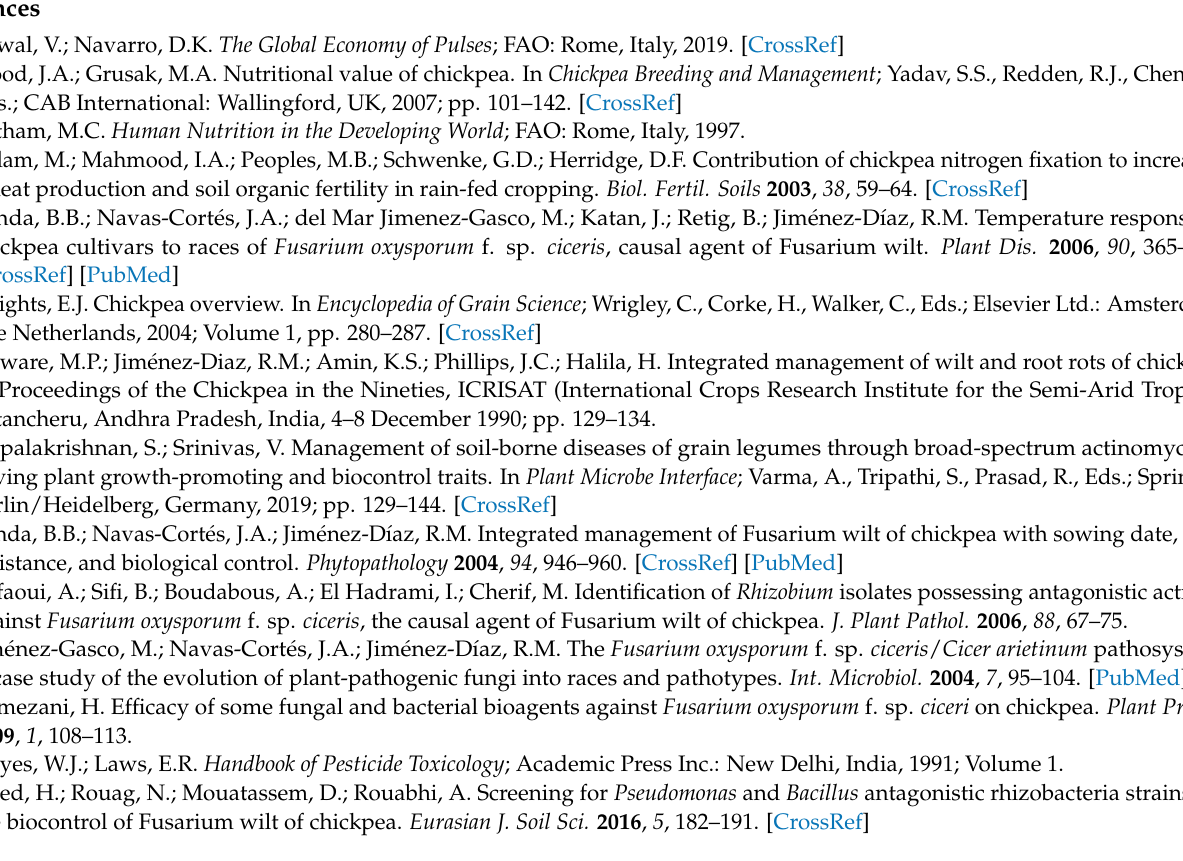
Figure S6: Phylogenetic tree of strain E1FP13 constructed by neighbor-joining method with Bootstrap values supporting the branches shown at the nodes; the bar indicates the number of substitutions per site; Figure S7: Phylogenetic tree of strain E1PP7 constructed by neighbor-joining method with Bootstrap values supporting the branches shown at the nodes; the bar indicates the number of substitutions per site; Figure S8: Phylogenetic tree of strain E1PP15 constructed by neighbor-joining method with Bootstrap values supporting the branches shown at the nodes; the bar indicates the number of substitutions per site; Figure S9: Phylogenetic tree of strain E1FP4 constructed by neighbor- joining method with Bootstrap values supporting the branches shown at the nodes; the bar indicates the number of substitutions per